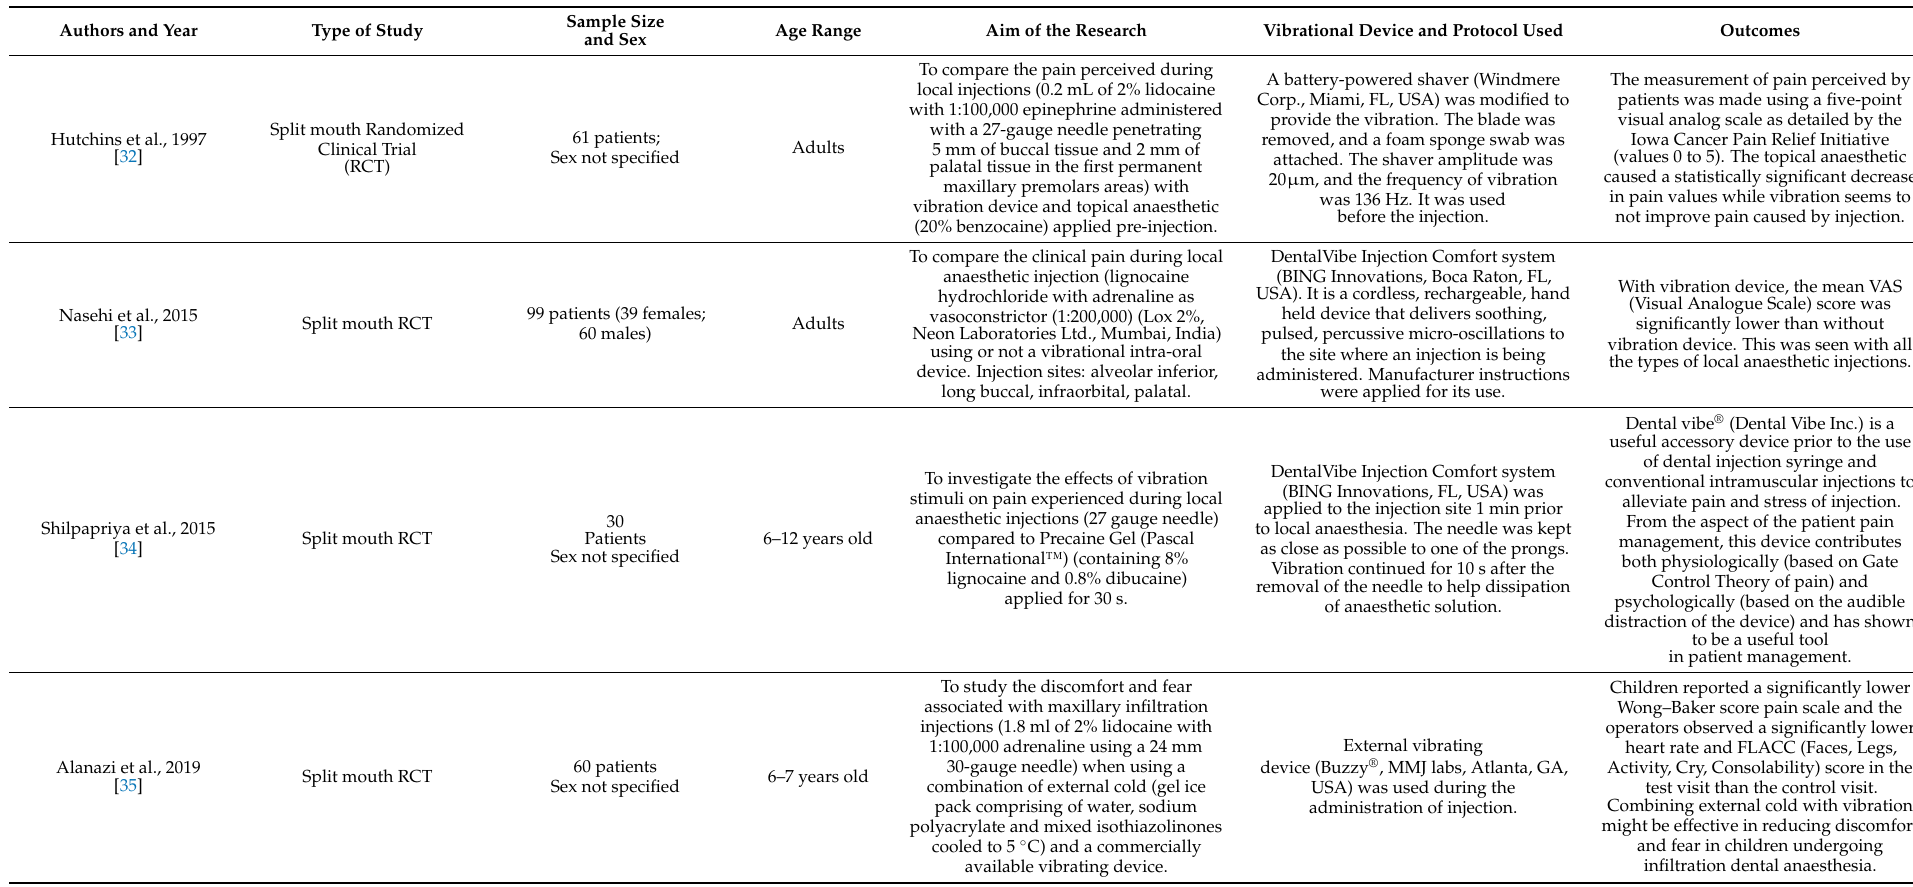
Table 3. Research articles included in the scoping